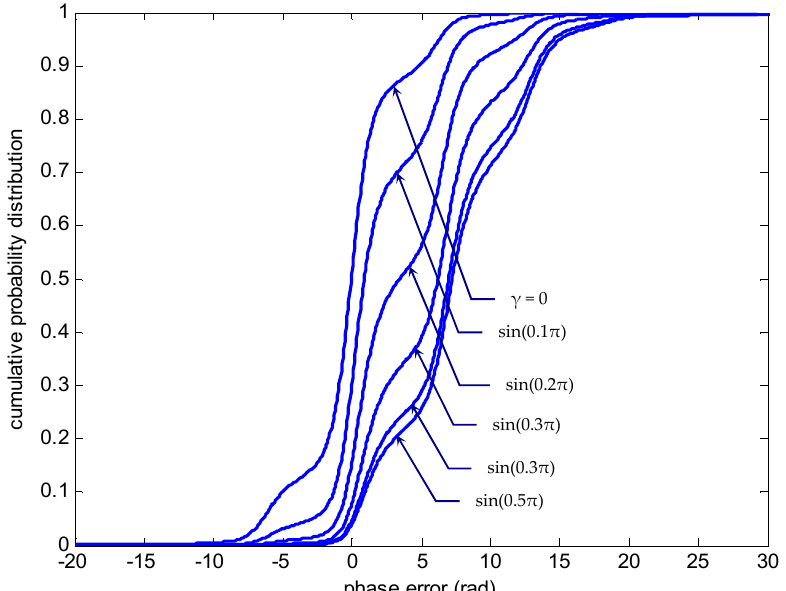
Figure 15. Nonmodulo-2 π phase-error cumulative probability distribution at τ = 10 for various detuning factors γ when SNR α = 1.